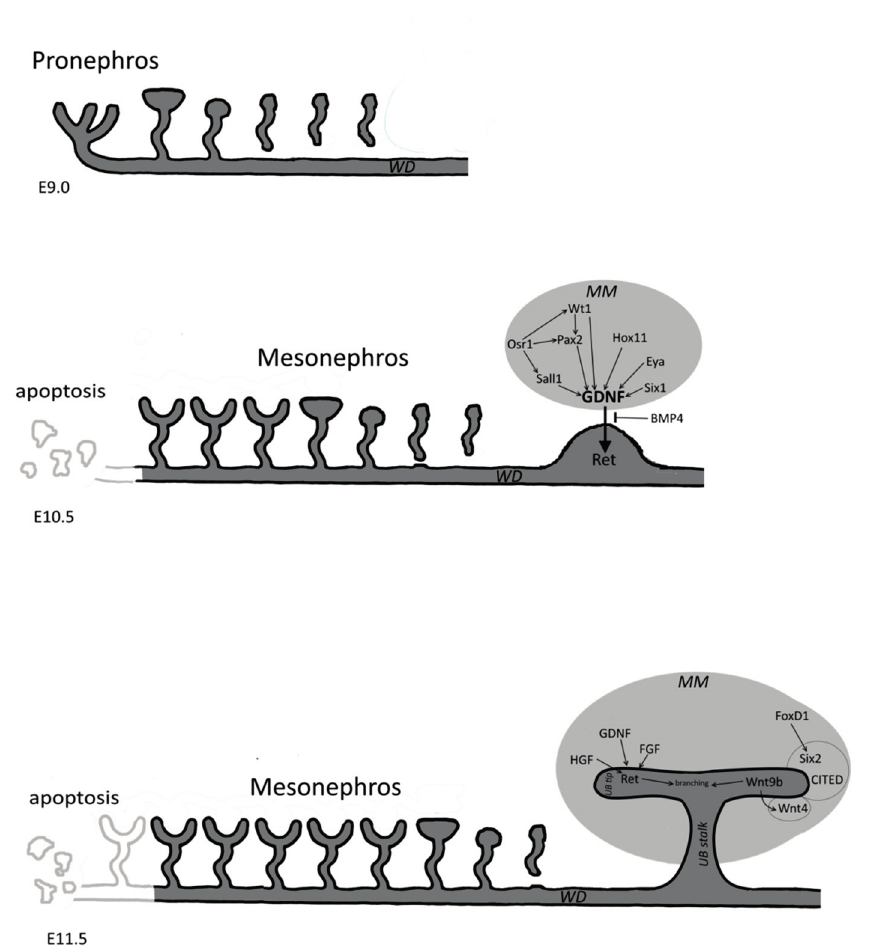
Figure 2. Schematic overview of the three stages of kidney development; the pro-, meso and metanephros between E9.0 to E11.5. The wolflian duct (WD) is shown in dark grey. Important signals during nephrogenesis which induce ureteric bud (UB) branching and metanephric mesenchyme (MM) differentiation are